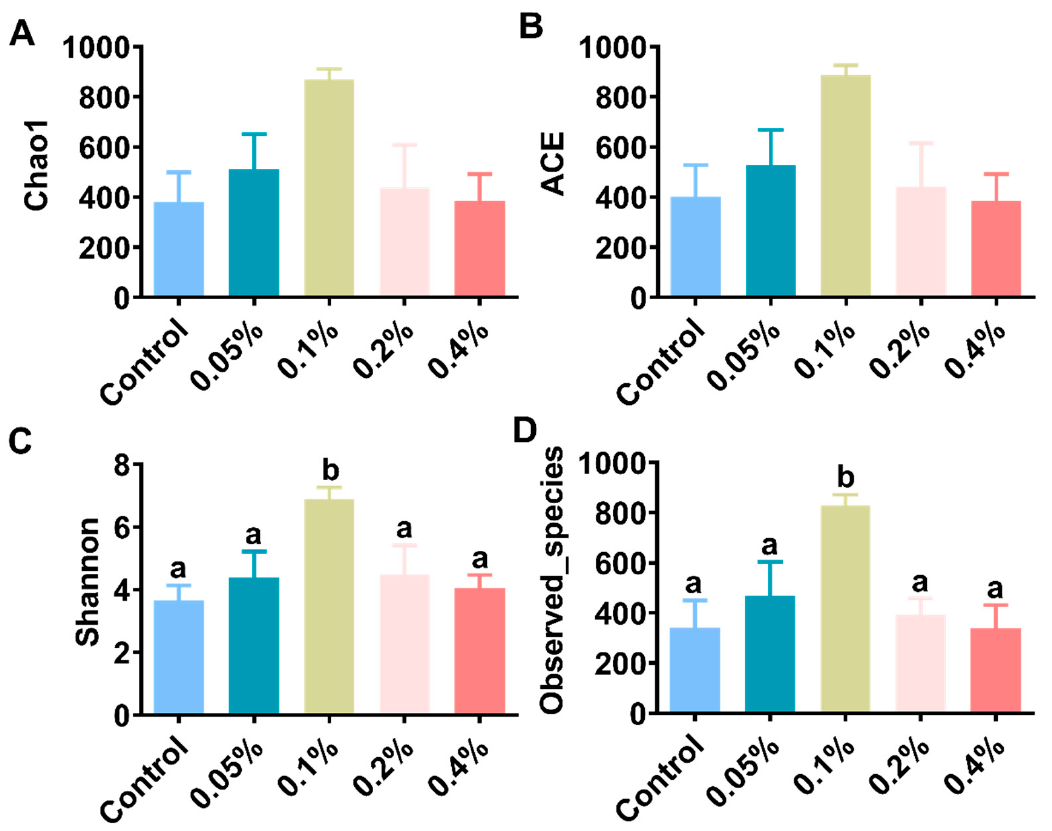
Figure 4. Effects of different doses of β -glucan on the alpha-diversity using ( A ) Chao1 estimator, ( B ) ACE estimator, ( C ) Shannon estimator and ( D ) observed species in gut microbiota in Juvenile L. vannamei . Different letters indicate significant differences ( p < 0.05) among groups. All data are expressed as the mean ± SE ( n = 4).